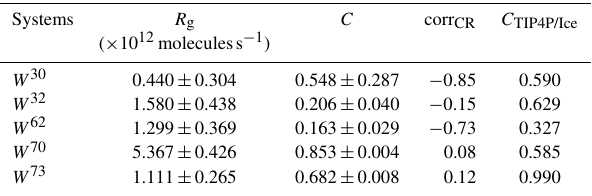
Table 2. Ice growth rates R g , cubicity C , and their correlation corr CR in different wedge systems using the mW water model, as well as the cubicity C TIP4P/Ice observed using the atomistic TIP4P/Ice model. Uncertainty values for the mW results show the standard deviation (instead of the usual standard error of the mean), applied in the normalization of the calculation of